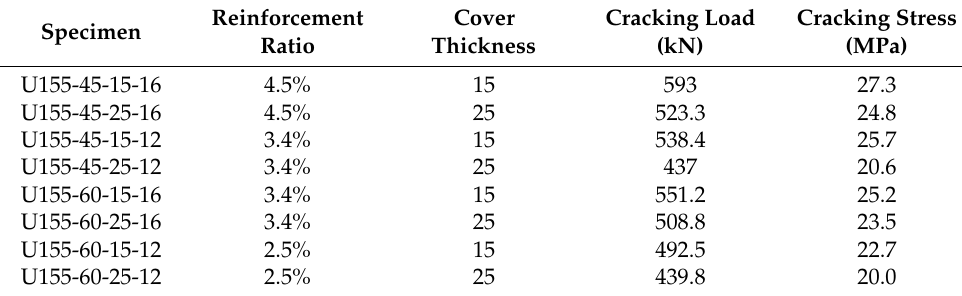
Table 4. Main test results of steel-UHPFRC composite beams.